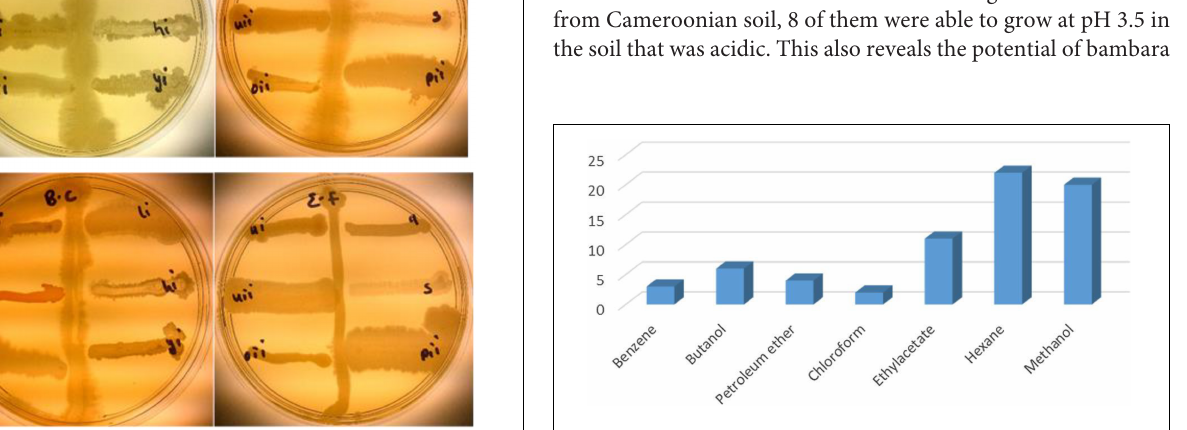
FIGURE 11 | Total number of metabolites detected by GC–MS in B. thuringiensis, B. amyloliquefaciens , and Bacillus sp. using seven different extraction solvents ( Source: Ajilogba and Babalola,